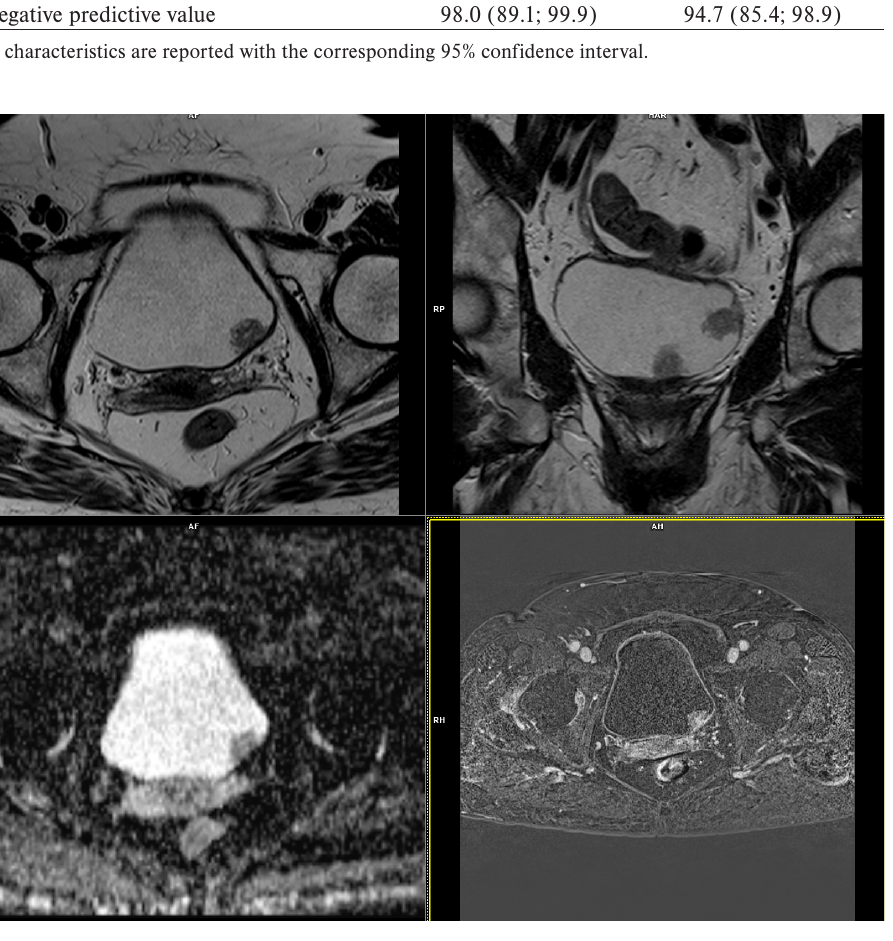
Fig. 3. VI-RADS 2 score